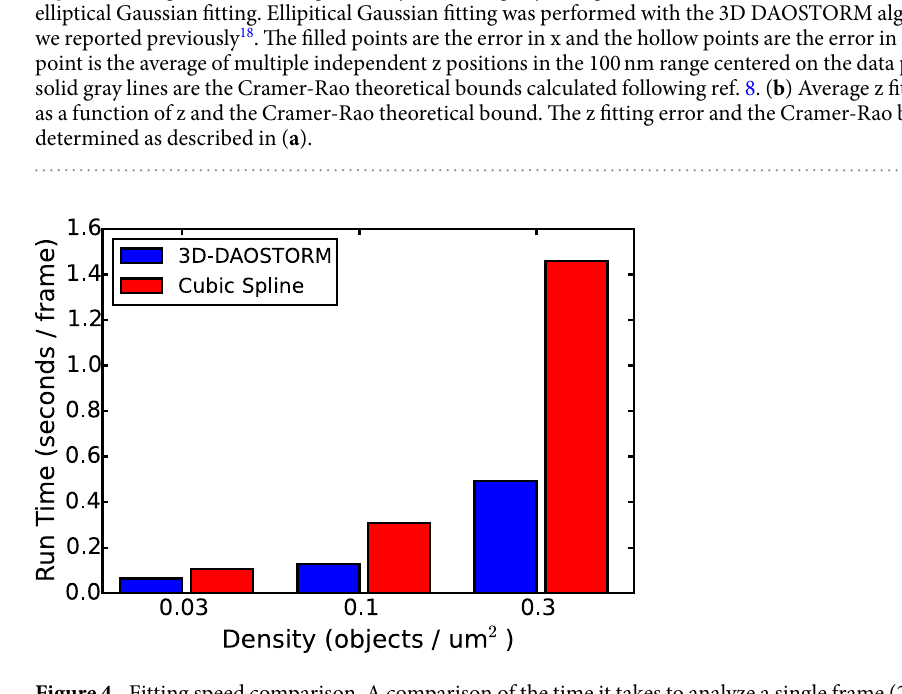
Figure 4. Fitting speed comparison. A comparison of the time it takes to analyze a single frame (256 × 256 pixels) of a simulated movie with indicated emitter densities using 3D-DAOSTORM or the cubic spline